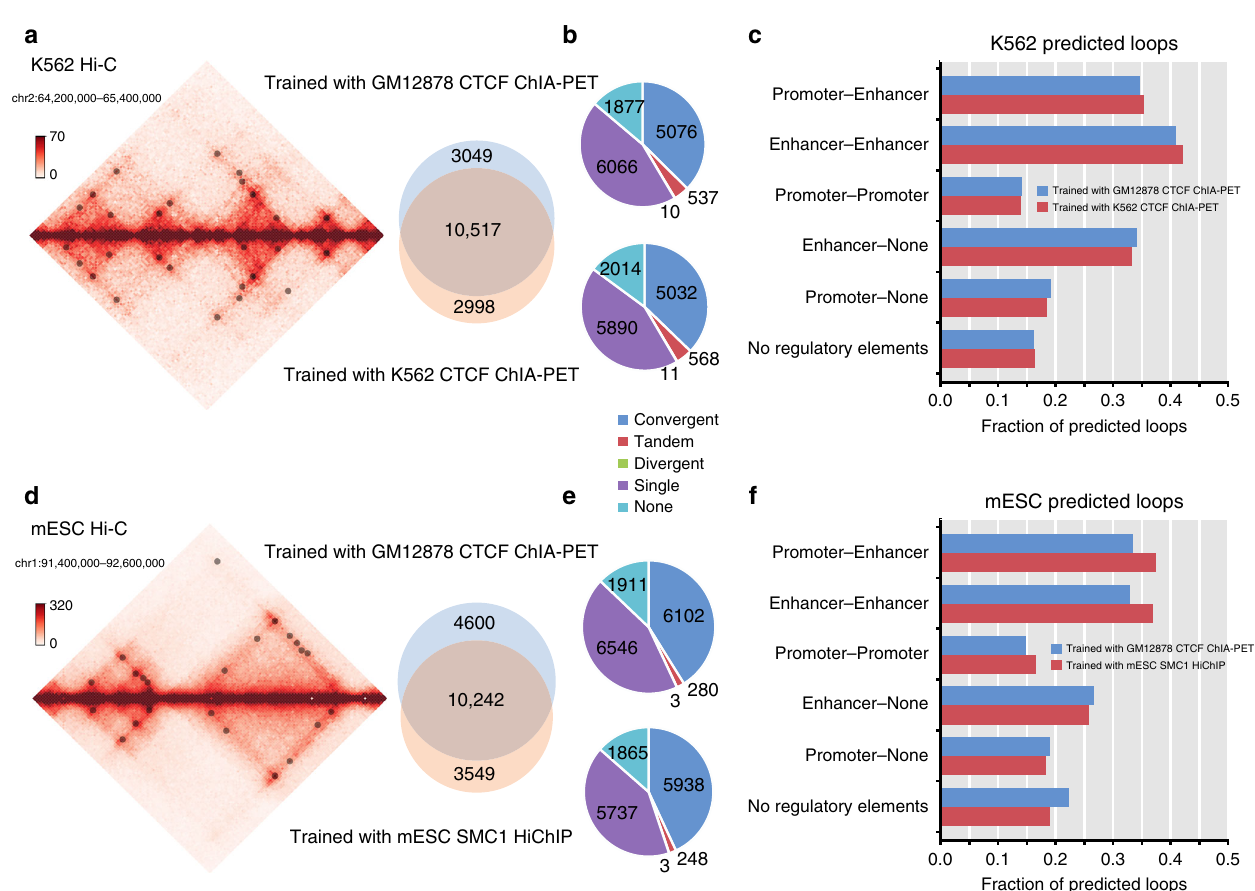
Fig. 5 Application of Peakachu in other Hi-C datasets of different tissues and species. a Overlap of loops predicted in K562 Hi-C by Peakachu models trained in either GM12878 or K562 data. Both models were trained with CTCF ChIA-PET examples. b CTCF binding orientations for predicted loops. c Regulatory elements at anchor loci of predicted loops. d – f Repeat analysis for loops predicted in mESC Hi-C by Peakachu models trained with either GM12878 CTCF ChIA-PET or mESC SMC1 HiChIP. Source data are available in the Source Data fi